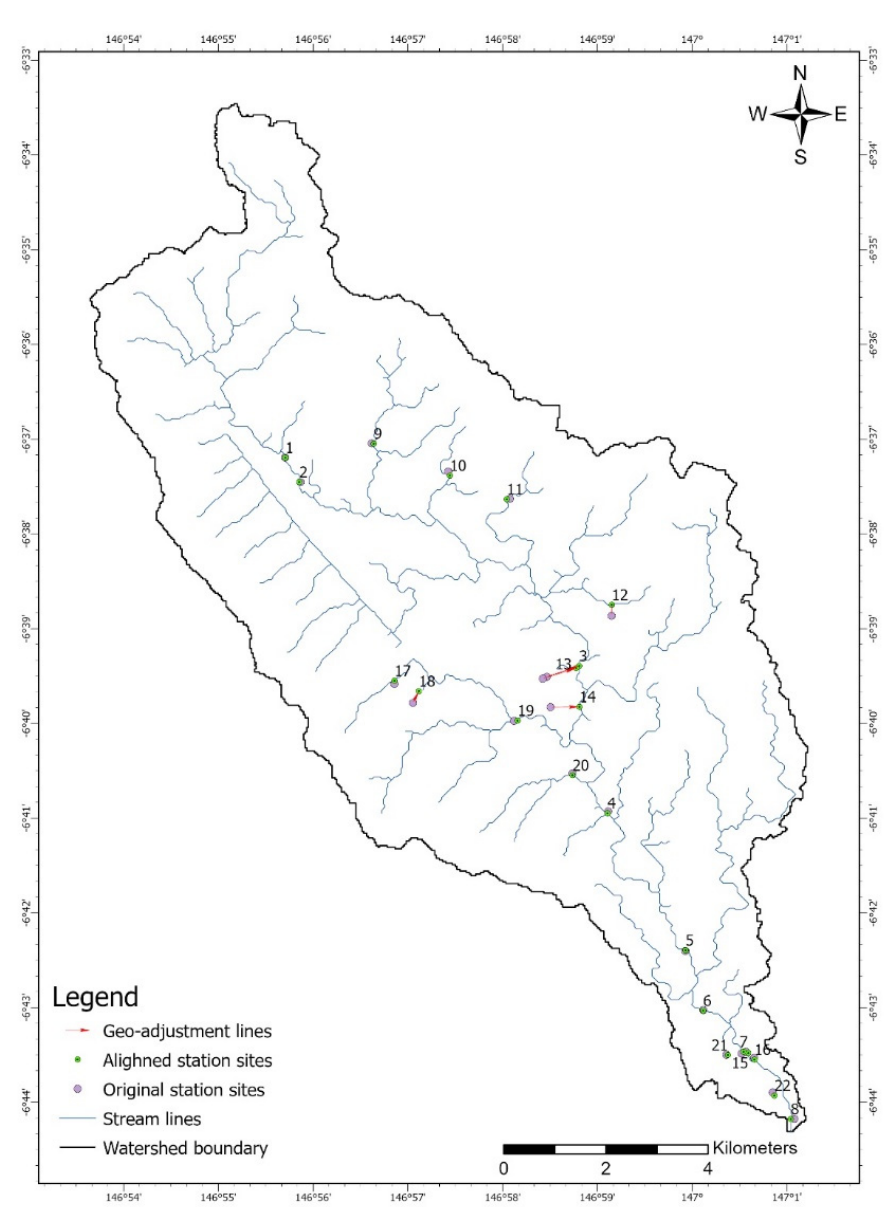
Figure 9. Geo-adjustment of sample site locations to coincide with imprecise Digital Elevation Model (DEM) stream delineation. Points of largest deviation from derived points are